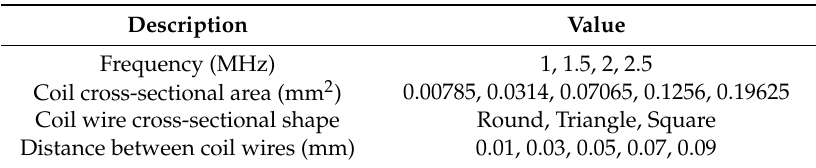
Table 2. Coil configuration parameters and excitation frequencies.